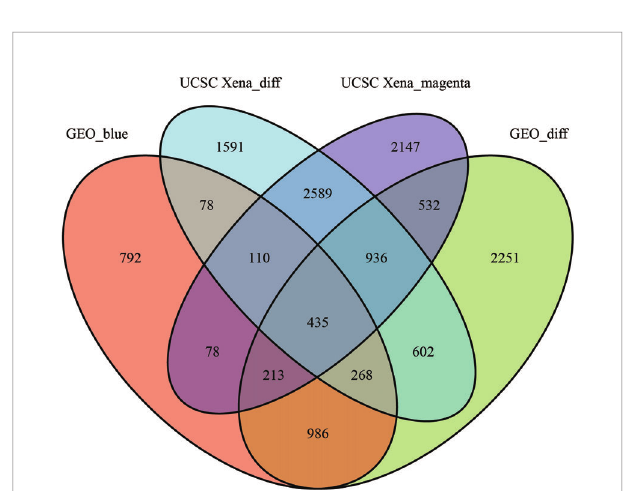
FIGURE 5 | The veenplots betweenDEGs andco-expressionmodules. Geo_blueindicates themostsigni fi cantmodule identi fi edbyWGCNA analysisof GSE3189; UCSCXena_diffindicates DEGs identi fi ed bythe UCSC Xenadatabase; UCSC Xena_magenta indicates DEGs identi fi edbyWGCNA analysis Themost signi fi cant modulesout;GEO_diff indicates DEGs identi fi